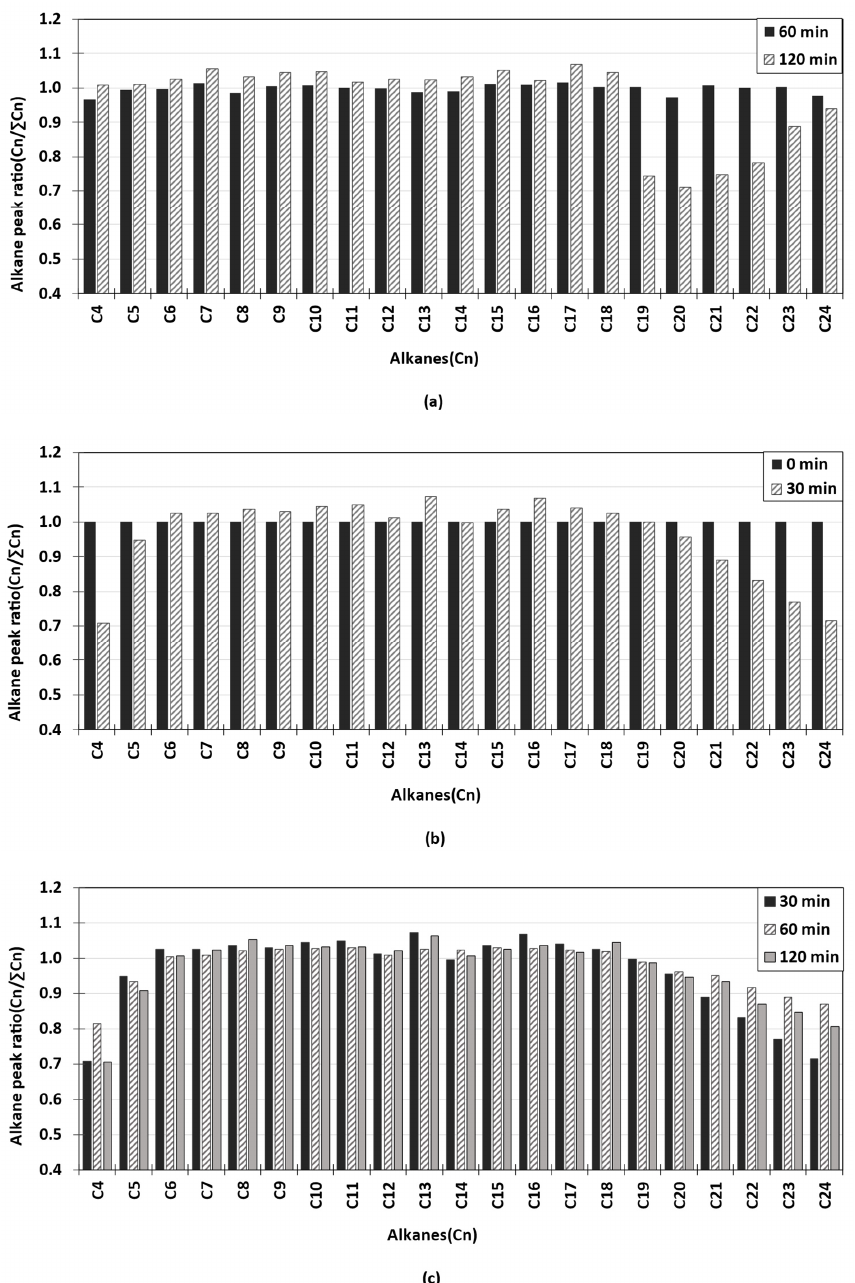
Figure 4. Variation of Alkanes (C n ) in BFO1 and BFO3 with ultrasonic irradiation: ( a ) from 60 to 120 min for BFO1; ( b ) from 0 to 30 min for BFO3; ( c ) from 30 to 120 min for